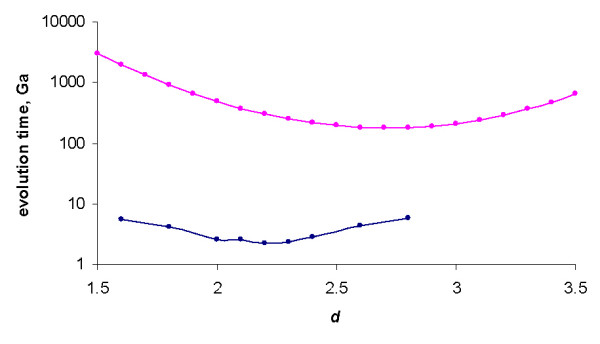
The time required for the formation of a first family with 1024 members starting from an ensemble of 3000 singletons (blue) compared to the mean time predicted by BDIMs of different orders (magenta). The model parameters are for Homo sapiens.